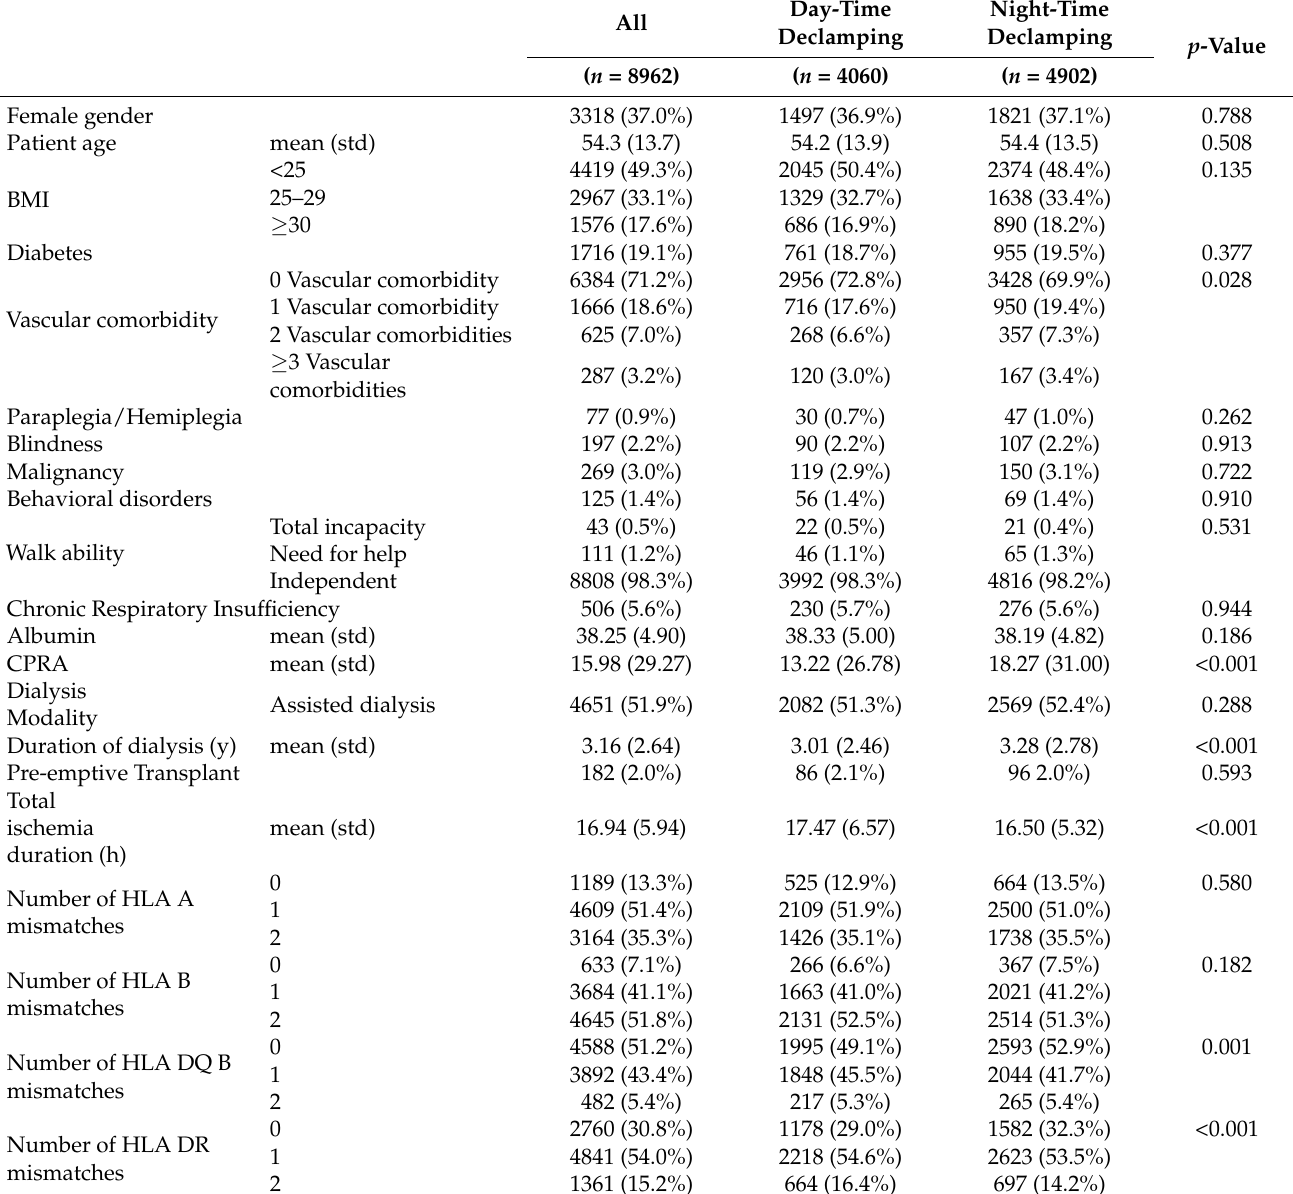
Table 1. Baseline characteristics of the studied cohort ( n = 8962) and grouped according to declamping time-of-the-day. BMI, body mass index; CPRA, calculated panel reactive antibody; HLA, human leukocyte antigen; p -value for night-time vs. day-time declamping by t -test or Chi-square